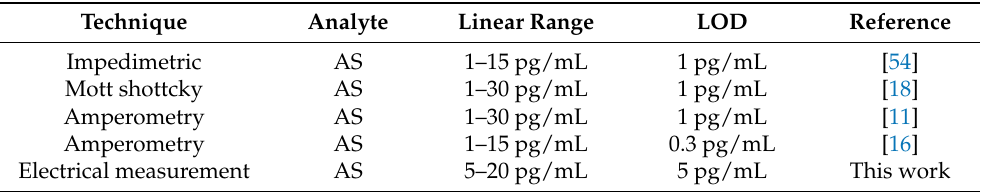
Table 1. Comparison of different electrochemical immunosensors for TNF- α detection.